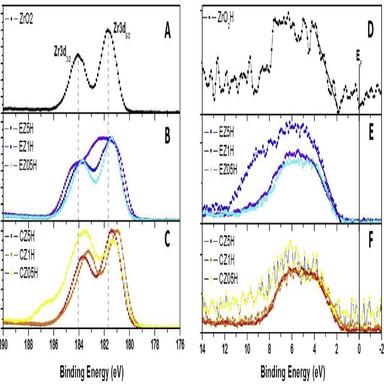
XPS Zr3d (AeC) and valence band region (DeE) high resolution spectra for the bare zirconia and the Er and Ce doped samples respectively.